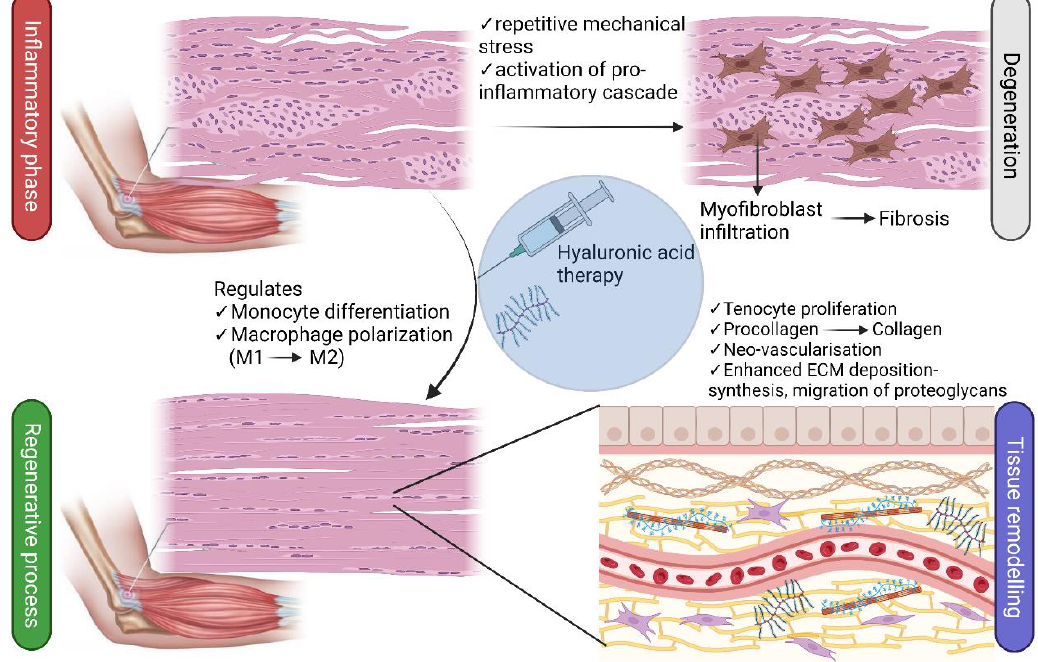
Figure 2. Hyaluronic acid in tendinopathies (Created with Biorender.com). Hyaluronic acid in orthopedic conditions. [https://app.biorender.com/, accessed on 20 December 2022].